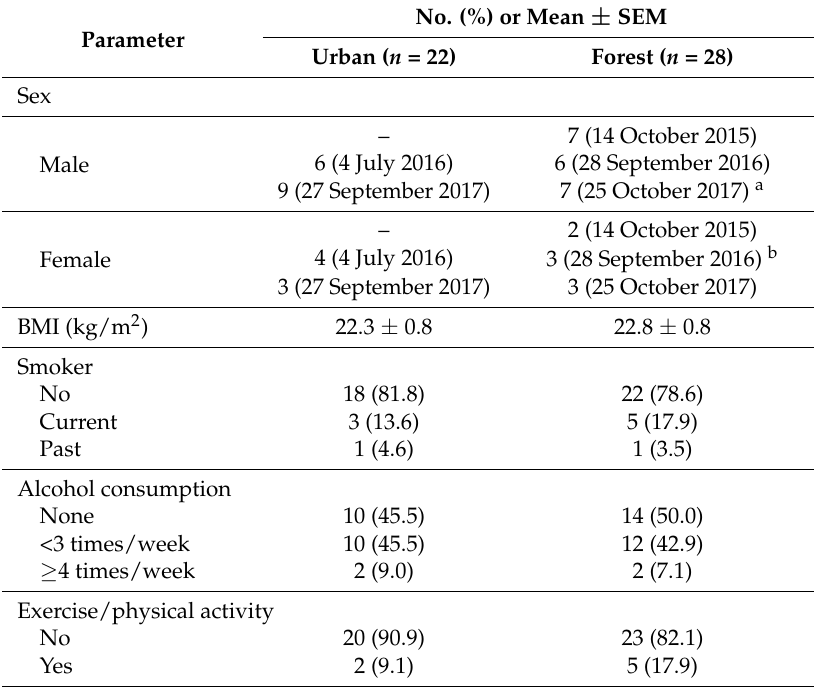
Table 2. Participants’